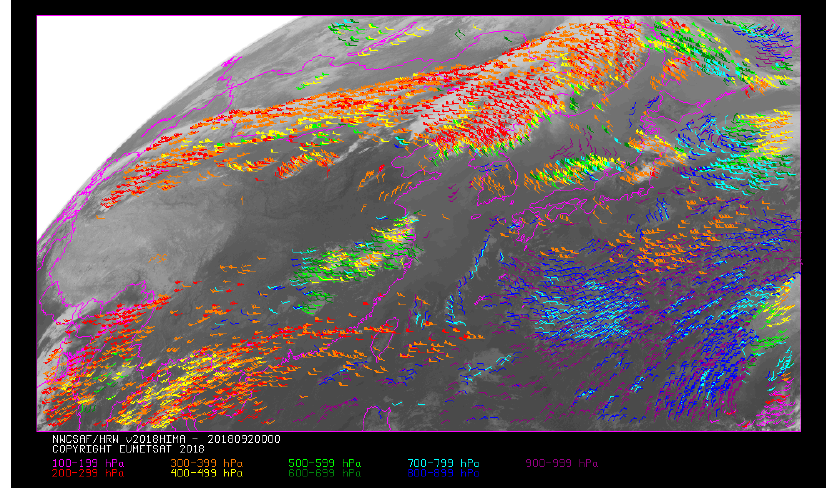
Figure 14. NWC/GEO-HRW v2018.1 AMV output example in the China/Korea/Japan region considering the default conditions for processing (2 April 2018, 00:00 UTC, Himawari-8 satellite). Color coding based on the AMV pressure. Table 5. Validation for NWC/GEO-HRW v2018.1 AMVs against radiosonde winds, considering all AMVs together and in three separate layers: high levels: 100–400 hPa; medium levels: 400–700 hPa; low levels: 700–1000 hPa (Mar 2018–Aug 2018, 00:00 UTC, Himawari-8 satellite, China/Korea/Japan region).